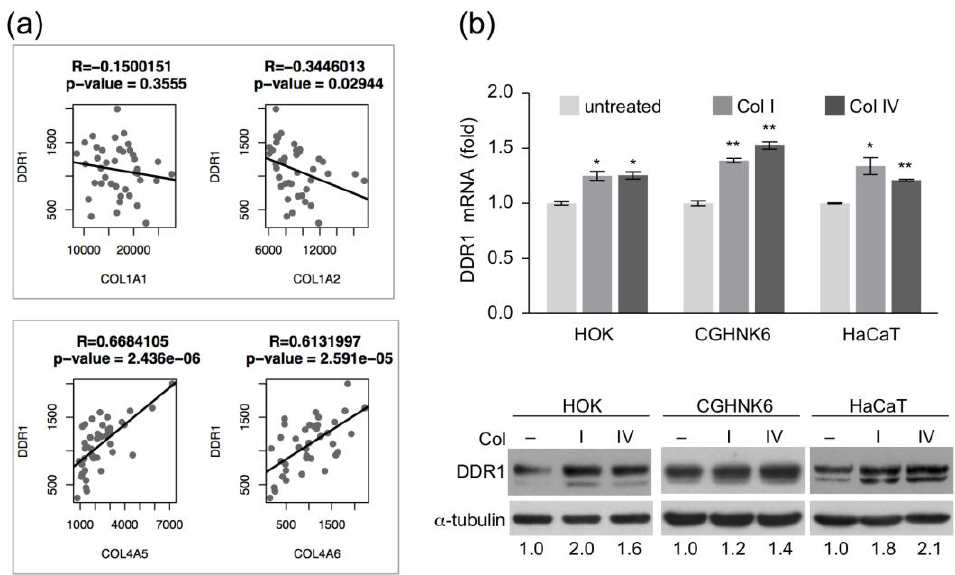
Figure 2. Correlation of collagen and DDR1 expression in vivo and in vitro. ( a ) Pearson correlation analysis between the expression levels of DDR1 and that of collagen type I (upper panel) and type IV (lower panel) in the 40 tumor tissues of NCKU-OrCA-40TN. DDR1 is positively correlated with COL4A5 and –A6, but not COL1A1 or –A2. ( b ) (upper) RT-qPCR assay of DDR1 mRNA levels in human keratinocytes treated with collagen (Col I or Col IV, 10 μg/mL) for 12 h. Data are presented as mean ± SD from triplicate assays. Statistical evaluation was performed with Student’s t -test. * p < 0.05; ** p < 0.01. Similar results were obtained from two experiments; one set of data is shown (lower). Western blot analysis of DDR1 protein levels in human keratinocytes treated with type I or type IV collagen for 24 h α-tubulin served as an internal control.